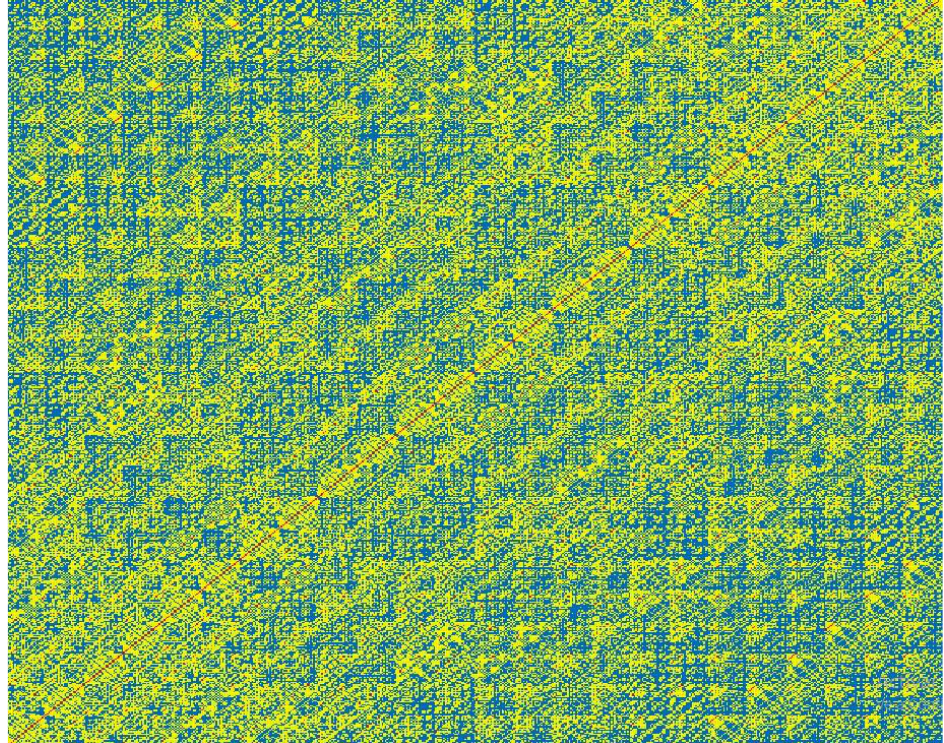
Figure 15. Color map (or heatmap) for the Borda method with n = 4.